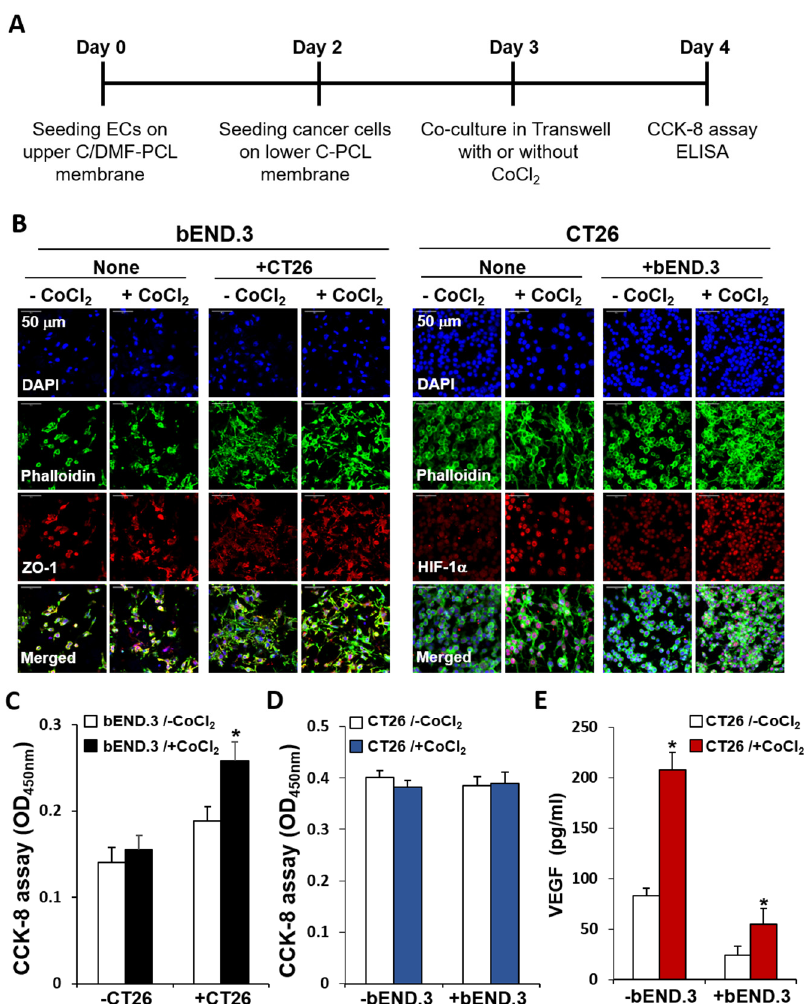
Figure 10. Increased growth of ECs by CoCl 2 in the co-culture. ( A ) bEND.3 and CT26 cells (3 × 10 4 ) were cultured alone or co-cultured ( n = 3) as shown in the workflow diagram, to investigate the e ff ects of CoCl 2 on the growth of bEND.3 cells in a modified two-layer co-culture system. ( B ) The distribution and morphology of fluorescent antibody-labeled cells on the upper (bEND.3) and lower layers (CT26) were analyzed via confocal microscopy. ( C ) The proliferation rate of bEND.3 cells was determined via the CCK-8 assay after the ECs were cultured with ( + CoCl 2 ) or without ( − CoCl 2 ) CoCl 2 in the presence ( + CT26) or absence ( + CT26) of CT26 cells. ( D ) The proliferation rate of CT26 cells was determined after cancer cells were cultured with ( + CoCl 2 ) or without ( − CoCl 2 ) CoCl 2 in the presence ( + bEND.3) or absence (-bEND.3) of bEND.3 cells. ( E ) CT26 cancer cells were cultured as in panel D and VEGF concentrations were determined via ELISA. Images represent three independent experiments. Data are presented as mean ± SD values ( n = 3). * p < 0.05, compared to cultures without CoCl 2.